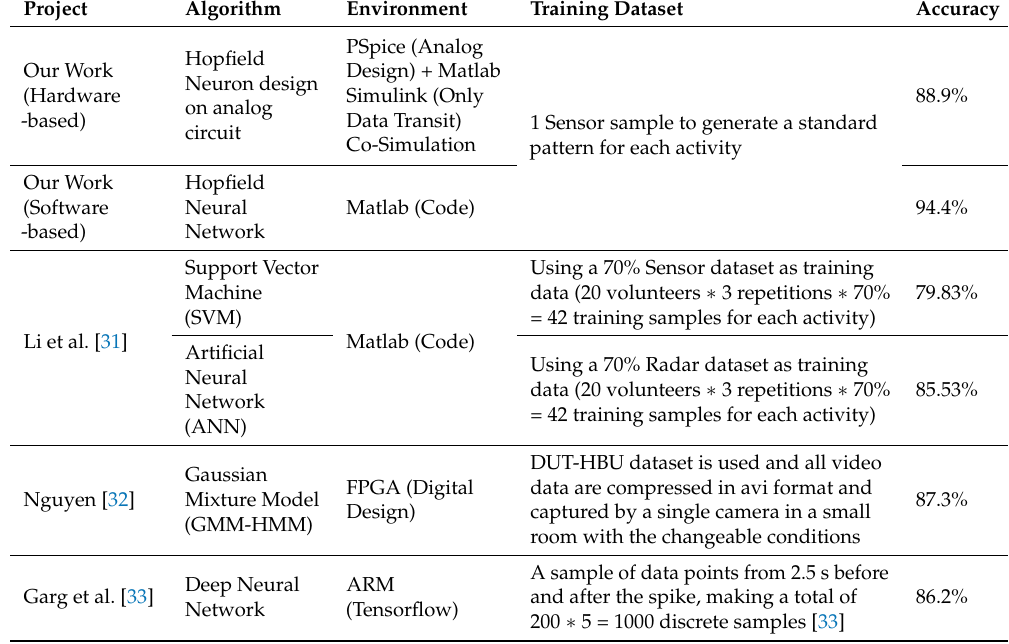
Table 1. Comparison table with different methods and